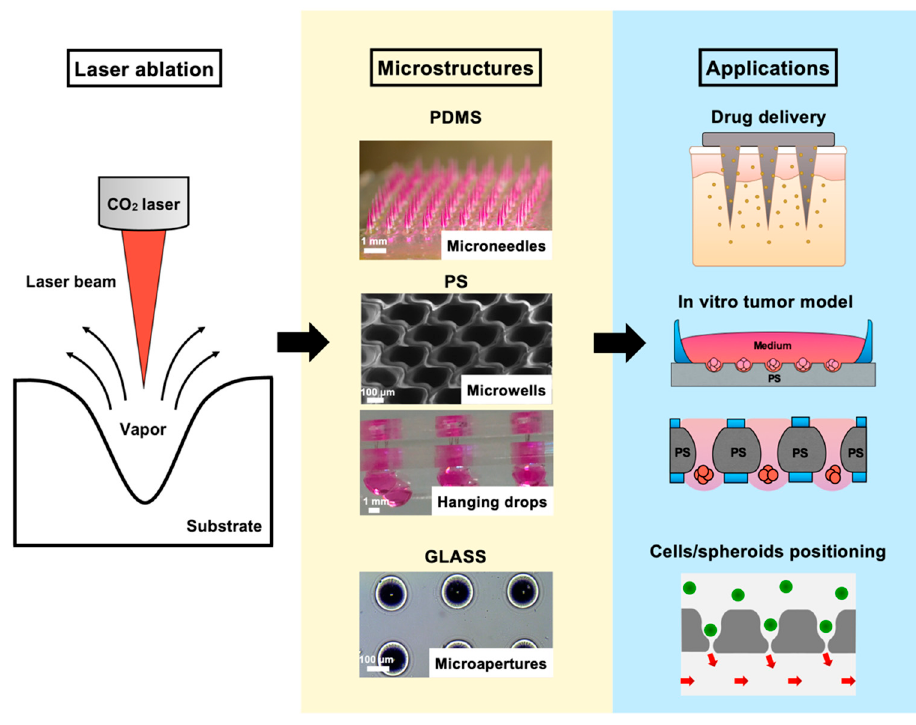
Figure 1. Illustration and images of the rapid laser drilling of different biocompatible materials for various downstream applications, including polydimethylsiloxane (PDMS) microneedle (MN) array molds for transdermal drug delivery; PS microwell/hanging drop arrays for 3D cell culture of in vitro tumor models, and glass macroapertures for trapping/positioning cells/spheroids (green) by a suction force (red arrows).